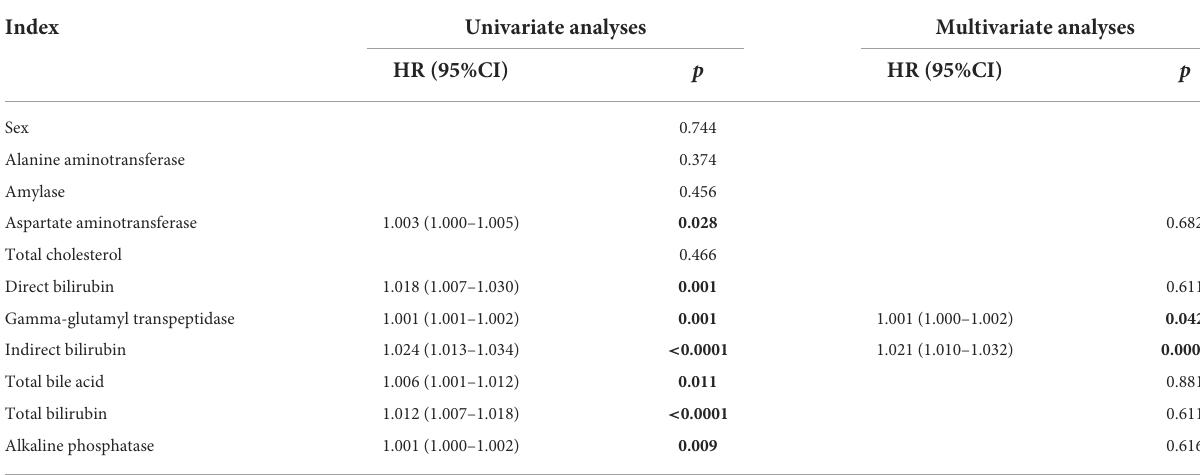
TABLE 3 Cox univariate and multivariate